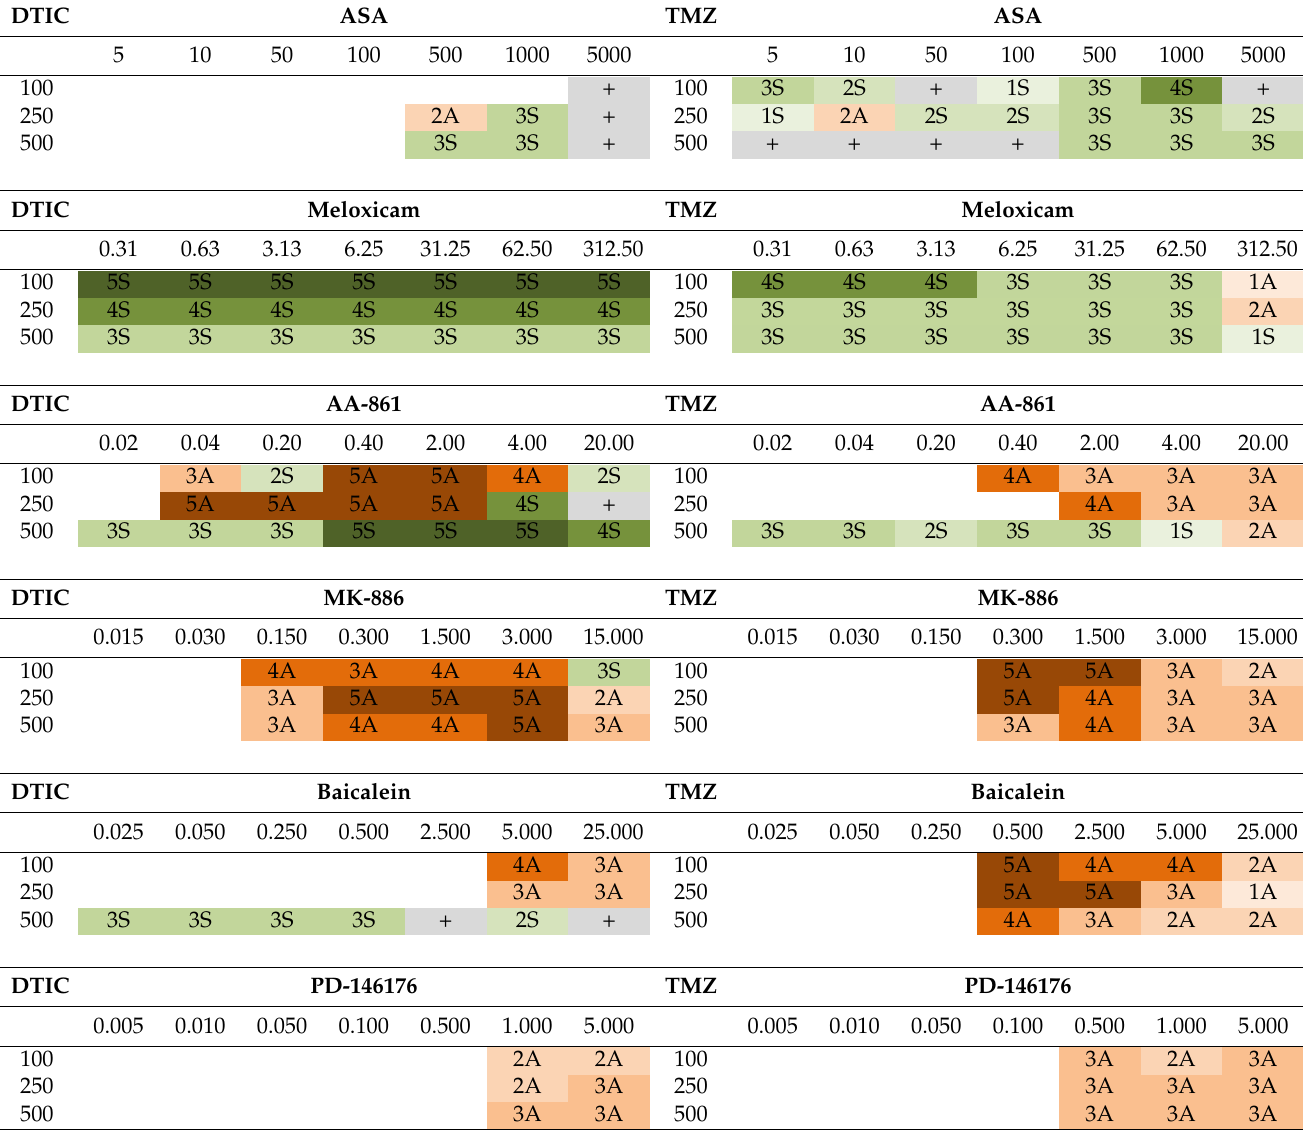
Table 1. Heat map of the synergy-antagonism of combination treatments (cytotoxicity on B16F10 after 72 h incubations). ( 5S ) Very strong synergism (CI < 0.1); ( 4S ) Strong synergism (CI = 0.1–0.3); ( 3S ) Synergism (CI = 0.3–0.7); ( 2S ) Moderate synergism (CI = 0.7–0.85); ( 1S ) Slight synergism (CI = 0.85-0.90); ( + ) Nearly additive (CI = 0.90–1.1); ( 1A ) Slight antagonism (CI = 1.10–1.20); ( 2A ) Moderate antagonism (CI = 1.20–1.45); ( 3A ) Antagonism (CI = 1.45–3.3); ( 4A ) Strong antagonism (CI = 3.3–10); ( 5A ) Very strong antagonism (CI > 10). Empty cells denote “No combinatorial effect”. All concentrations are in µ